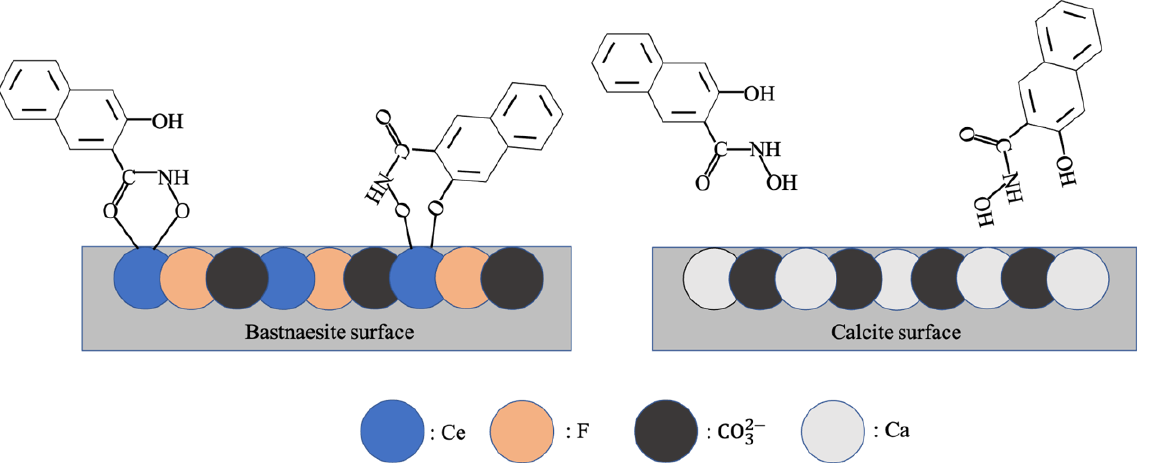
Figure 10. Reaction of NHA with bastnaesite and fluorite surfaces.